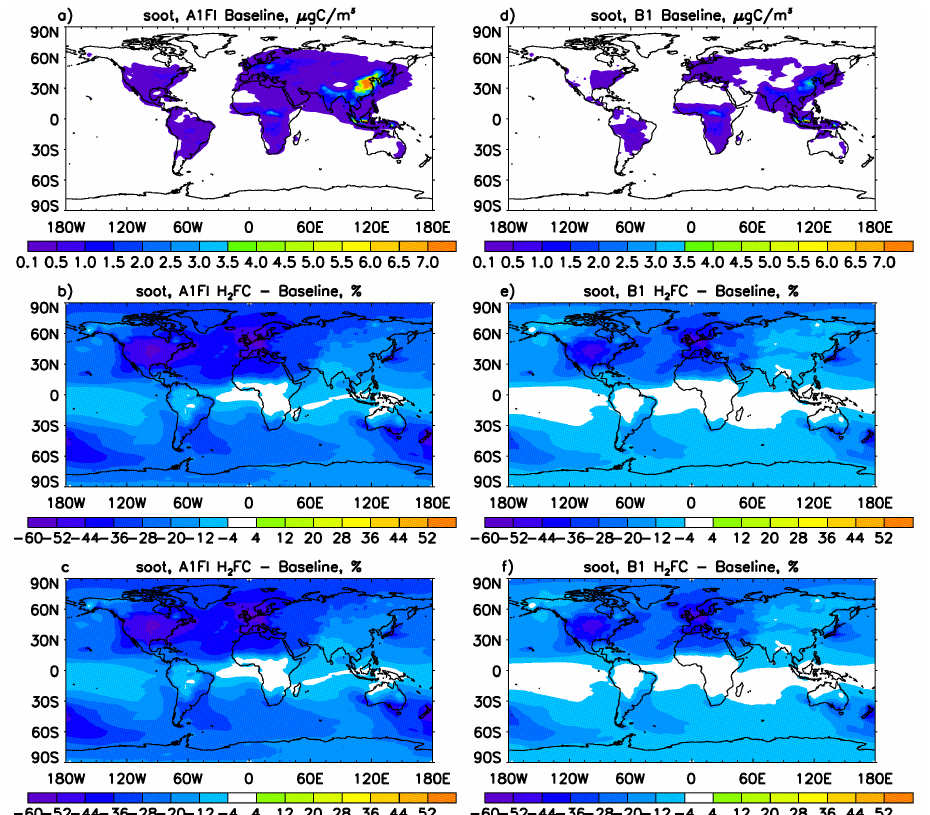
concentrations ( µ g/m 3 ) simulated by CMAQ for the 2 2.5 -FC scenarios (center: b and e), and differences 4 2 -ICE scenarios (right: c and f). Data are from the lowest 5 2